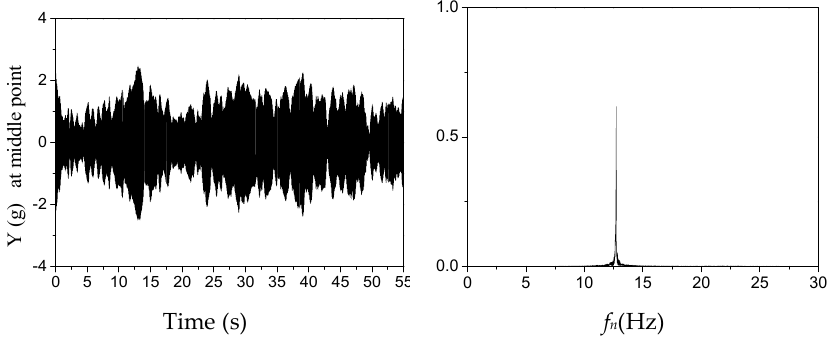
Figure 5. Crosswind oscillation details (U = 8.3m / s, U / f 0 D = 7.9) at the middle point of the three-dimensional (3D) prototype